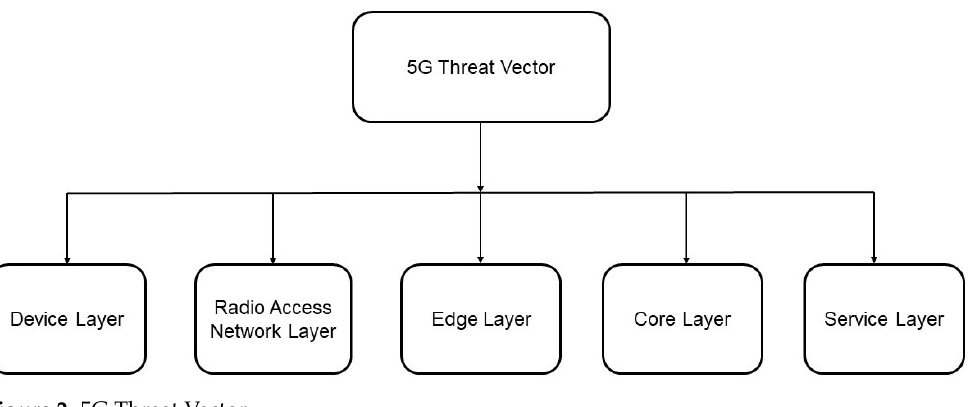
Figure 2. 5G Threat